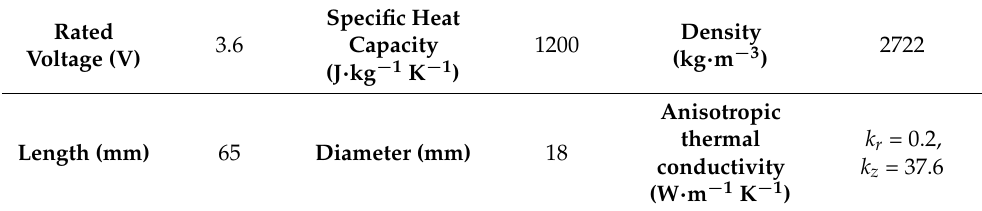
Table 1. Physical and thermal properties of the 18,650 li-ion battery